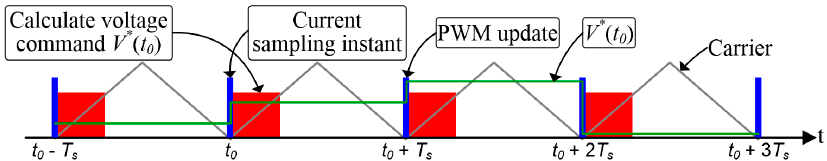
Figure 1. Time sequence for current sampling, voltage command calculation, and output, where PWM is pulse-width modulation.